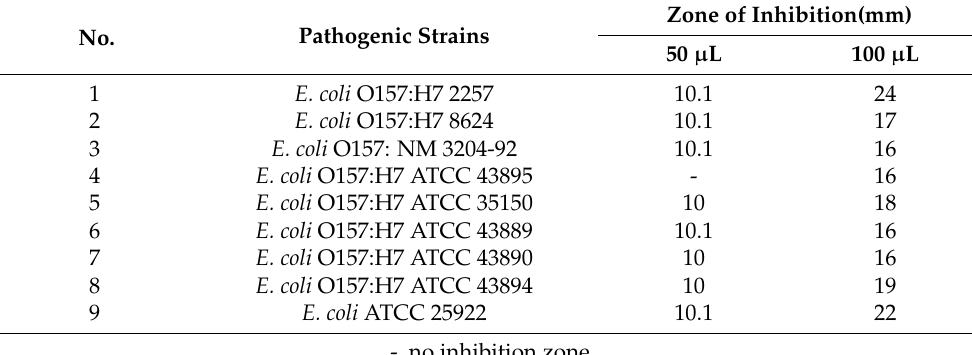
Table 4. Antibacterial efficacy of probiotic-mediated synthesized AgNPs against E. coli O157:H7